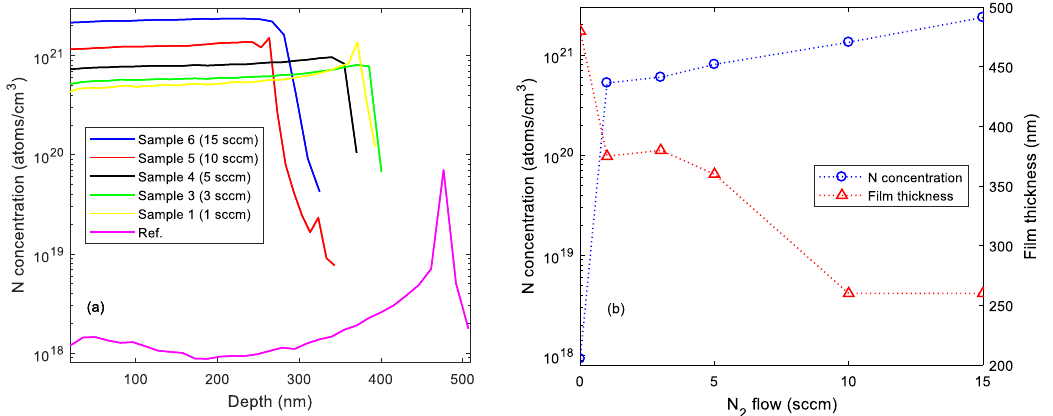
Figure 1. ( a ) Recorded SIMS depth profiles for N:Cu 2 O thin films deposited on quartz. ( b ) Nitrogen concentration and film thickness versus N 2 gas flow rate.